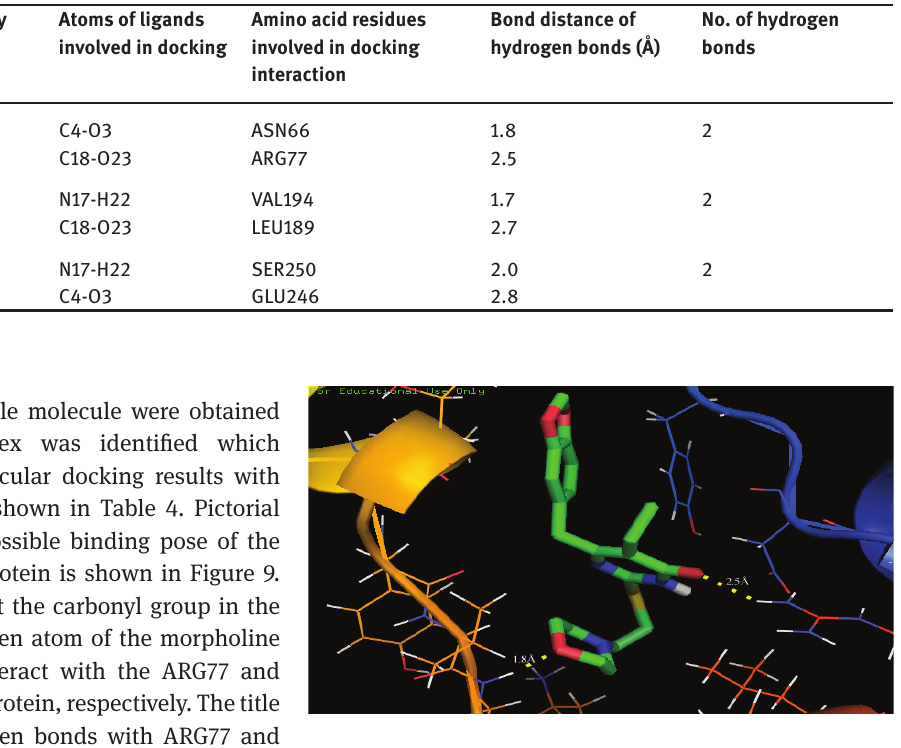
Figure 9 : Binding pose diagram of the title compound to its target